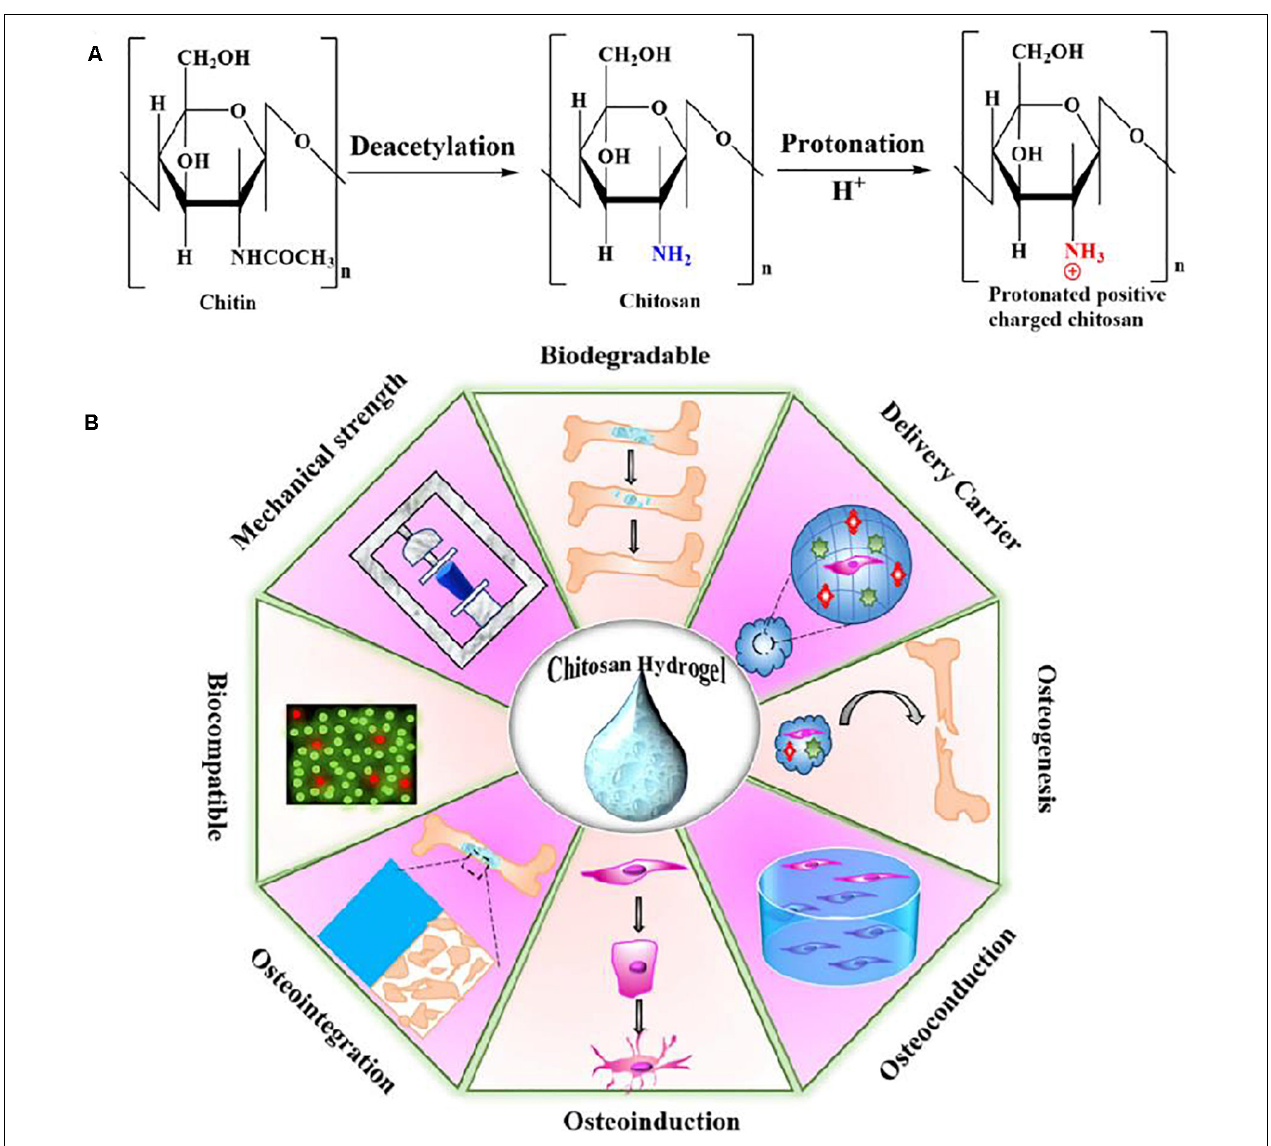
FIGURE 1 | (A) The chemical structures for the chitin, noncharged form of chitosan and protonated positive-charged chitosan. (B) Schematic representation of physio-chemical and biological properties of CS-based hydrogel. Reproduced from Lavanya et al. (2020) with permission from Copyright 2020